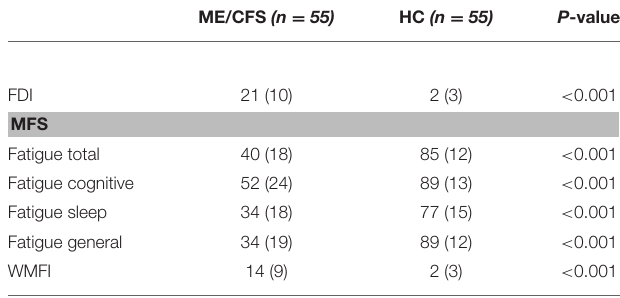
TABLE 2 | Comparison of self-reported frequency of Fukuda criteria symptoms in the preceding 2 weeks.